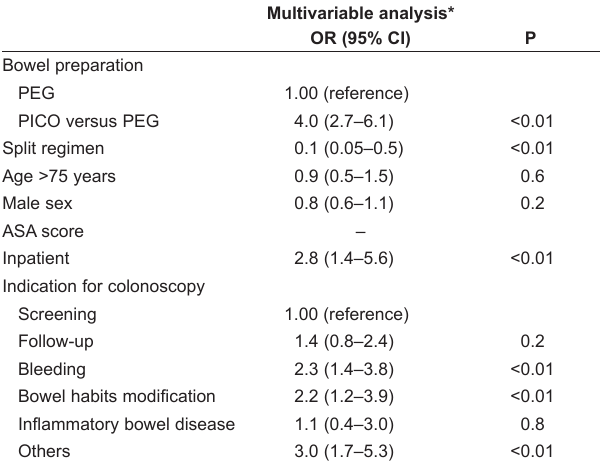
*Adjusted for all variables listed in the table. ASA American Society of